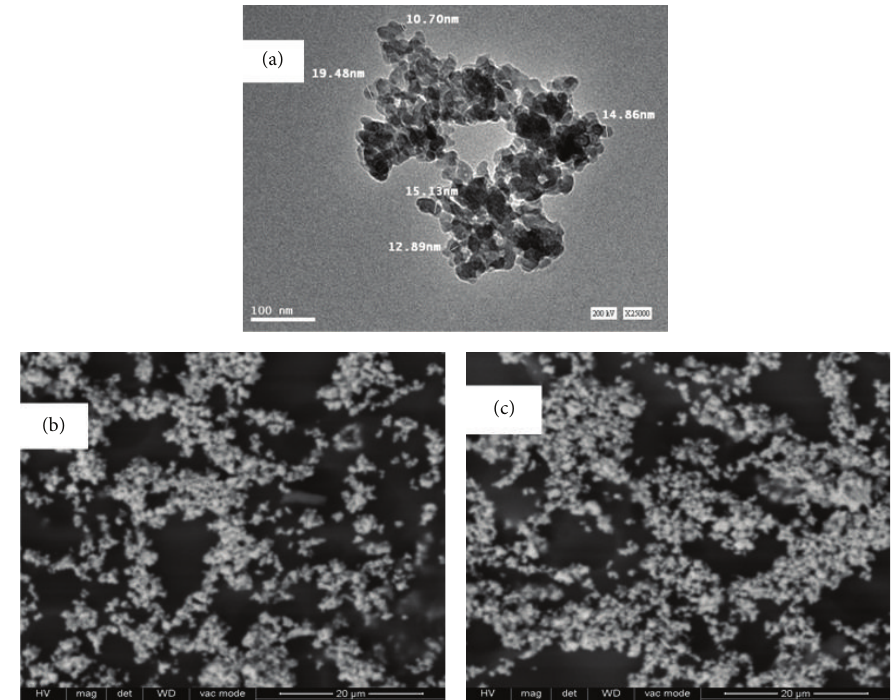
Figure 2: (a) HR-TEM of SiO 2 nanoparticles and SEM images for (b) 1wt% SiO 2 -doped PVC and (c) 4wt% SiO 2 -doped PVC.